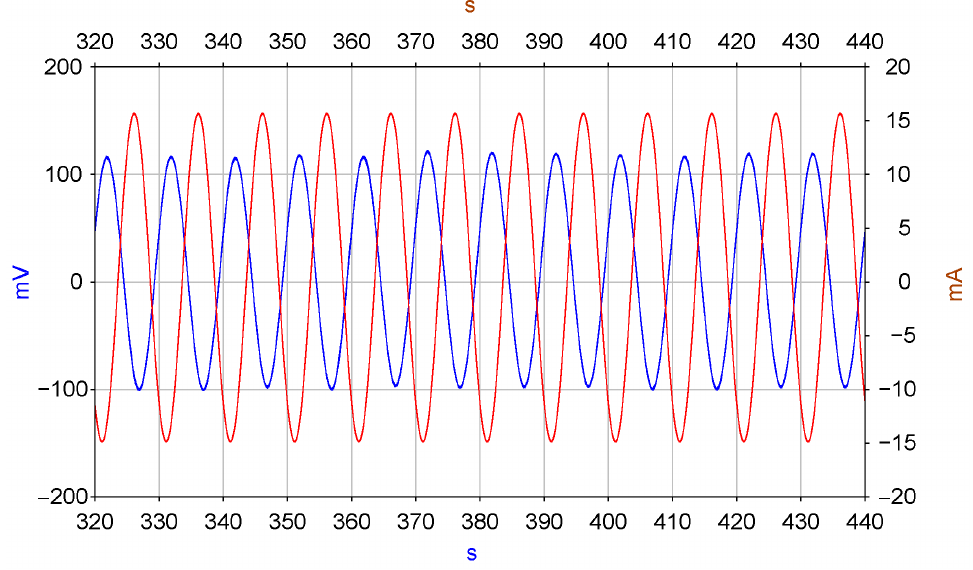
Figure 8. MET cell output signal (blue trace) and MHD cell current (red